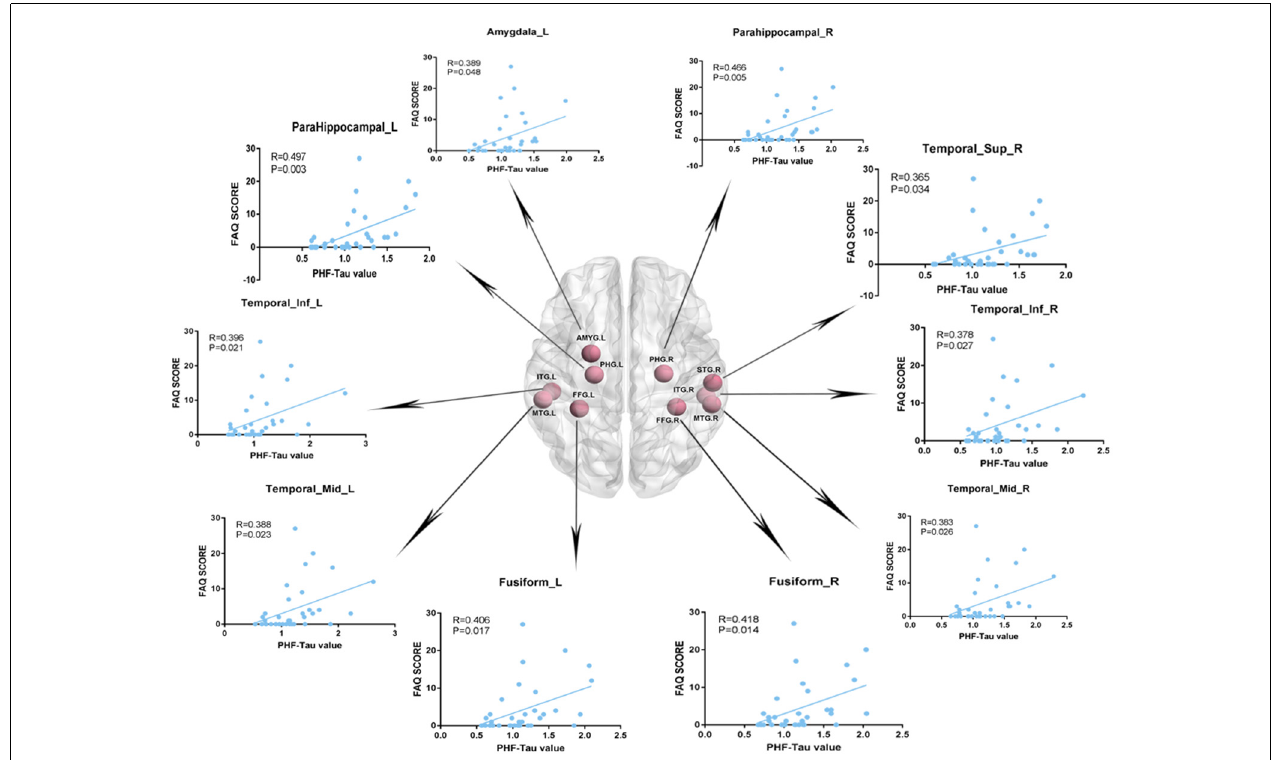
FIGURE 2 | Pearson correlation analysis between Functional Assessment Questionnaire (FAQ) scores and increased regions of paired helical filaments-Tau (PHF-Tau) value comparing the APOE 4+T+ group with the APOE 4 − T − group ( P < 0.05, FDR). Pink nodes represented the different significant region, and the Pearson correlation analysis results of the corresponding regions were marked by